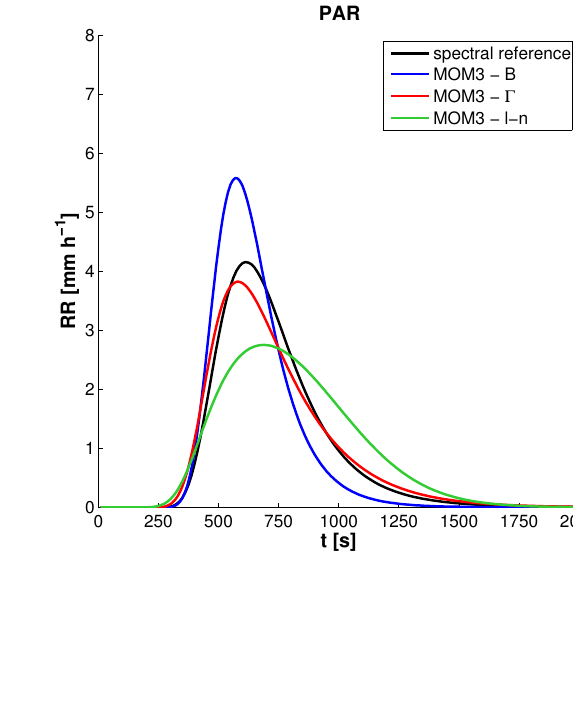
= 5 . 75 km) for the spectral reference solution Figure 7. Comparison of the rain rate (at z RR (black) and the MOM3 models (colors), in BOX case ( left ) and PAR case ( right